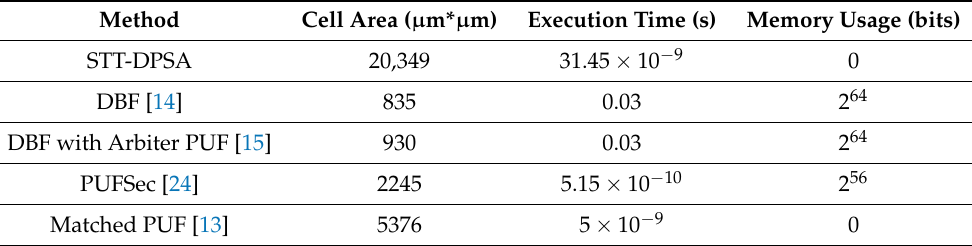
Table 3. Comparison